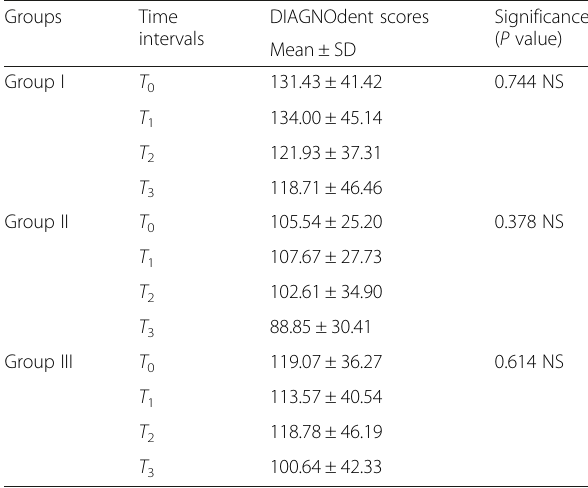
Table 4 Description of DIAGNOdent scores at various time intervals of observation among subjects of three groups Groups